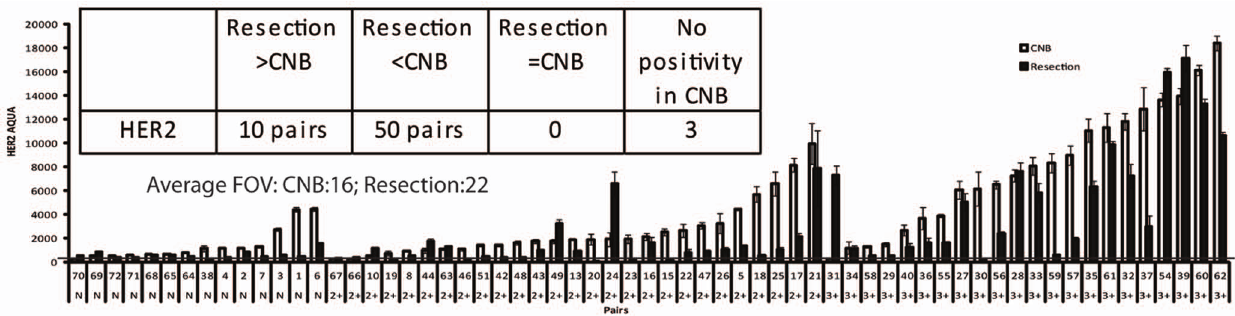
Figure 2. Expression of HER2 in tumor resections compared to CNBs. AQUA HER2 scores of 63 pairs of CNB (open bars) and tumor resection (filled bars) were assessed. Average FOVs of CNB: average number of FOVs included in analysis of CNB; Average FOVs of Resection: average number of FOVs included in analysis of tumor resection specimens. The noise cut point is marked with a solid line. Each AQUA score represents the mean 6 95% CI. The number of pairs where resections are higher, lower than CNBs, or equal to those of CNBs are listed in inset.